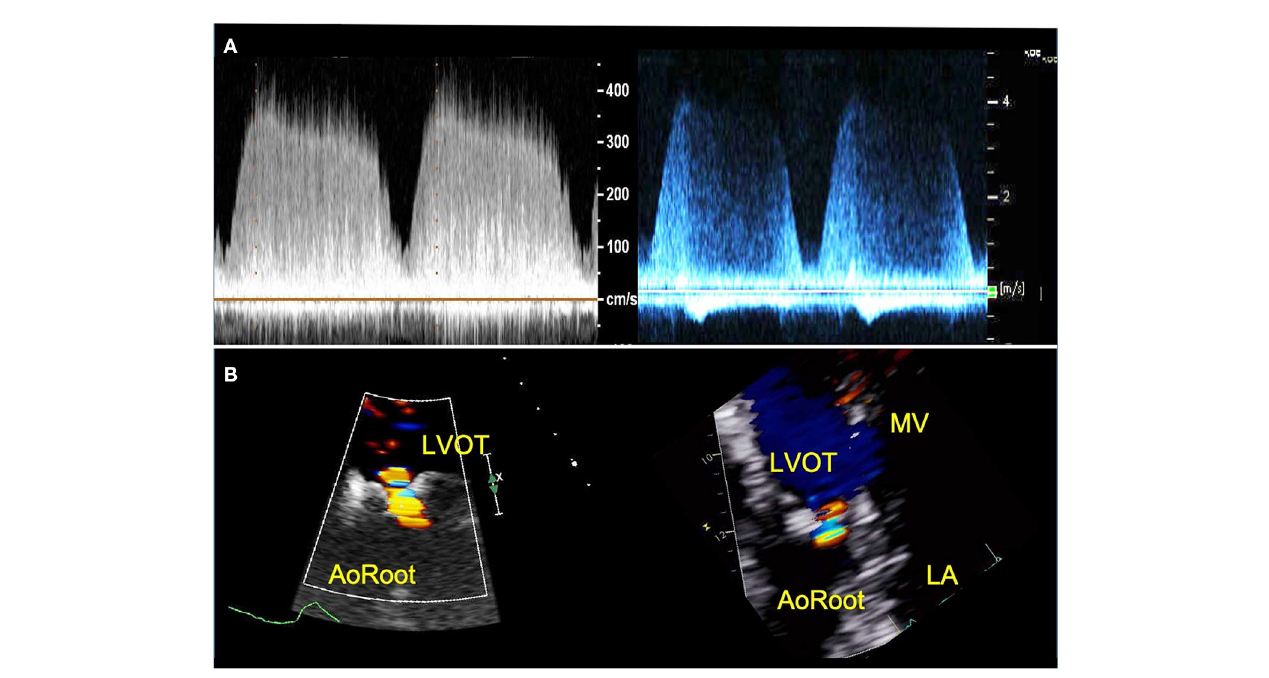
FIGURE4 TTE images of AR from patient (right) and 3D printed model within the circulatory flow loop (left). (A) Continuous wave Doppler of AR flow demonstrating comparable profiles and peak velocities; (B) color Doppler images or the regurgitant AR flow, for vena contracta measurement. LVOT, Left ventricle outflow tract; LA, left atrium; MV, mitral valve.